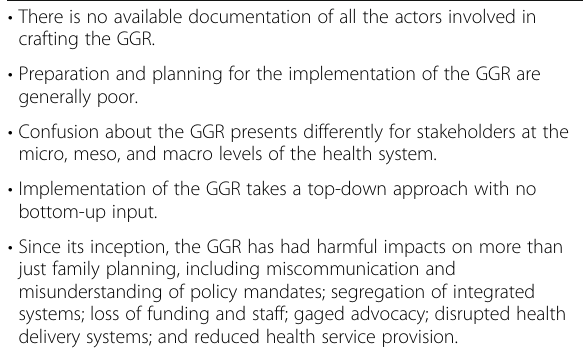
Table 6 The GGR- a poorly constructed and implemented